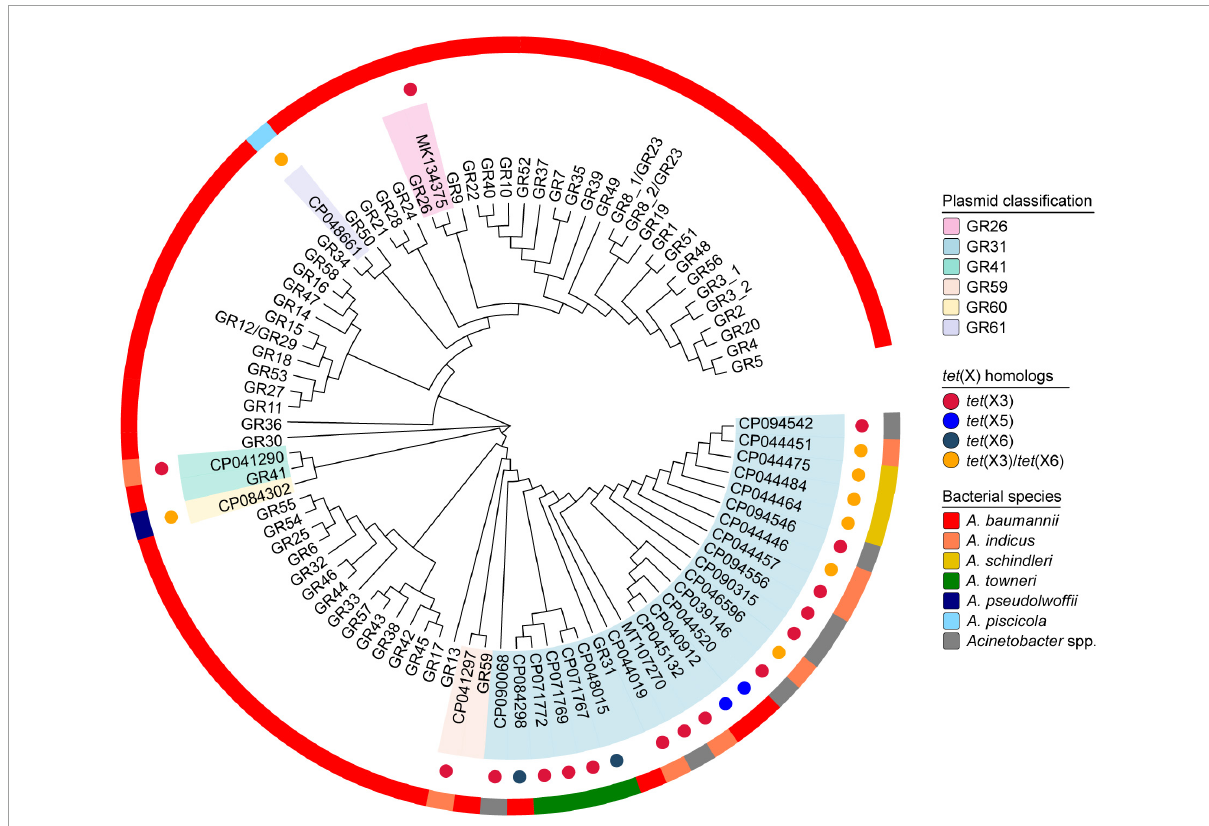
FIGURE2 Maximum-likelihood phylogenetic analysis of Acinetobacter spp. plasmids based on replication initiator proteins. In parallel, the plasmid classification, tet (X) homologs and bacterial species are indicated from the inside